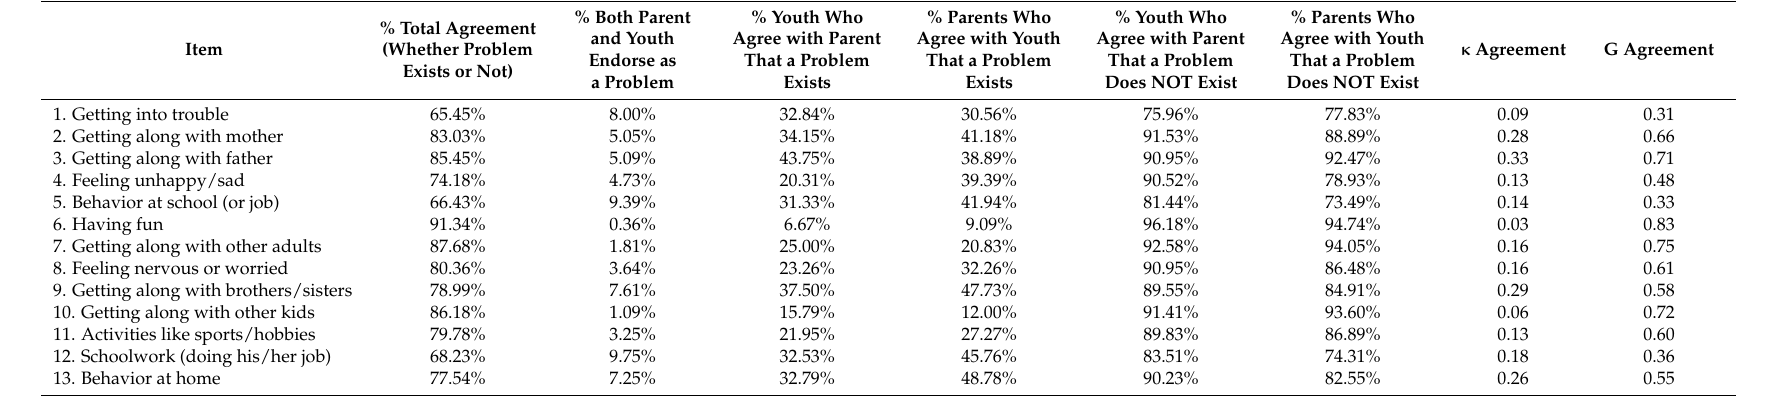
Table 2. Parent and youth agreement on problematic functional impairment